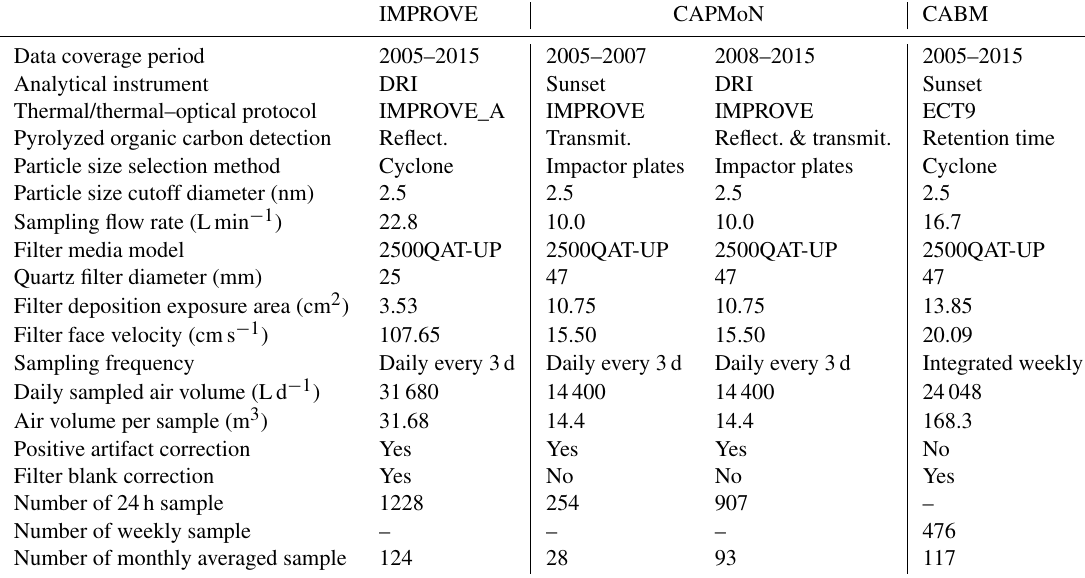
Table 1. Specifications for the filter sampling systems and analytical instruments/methods used by the three networks. IMPROVE